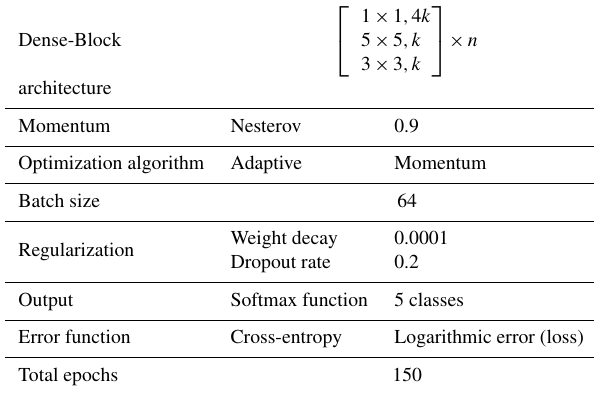
Table 2. Implementation details of the used DenseNet